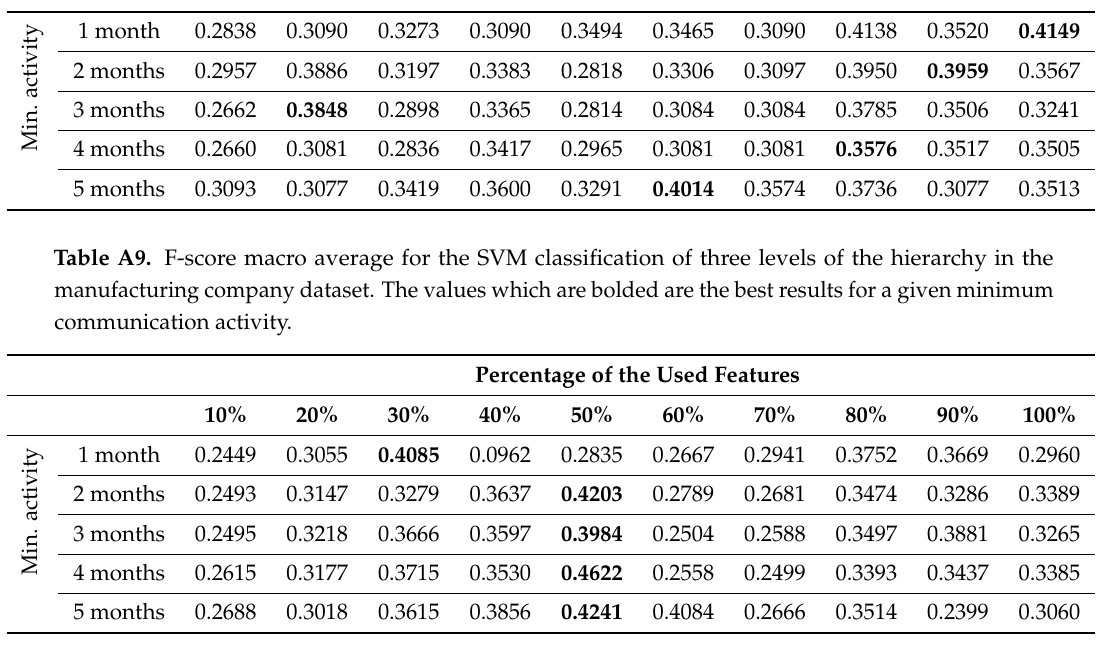
Table A10. F-score macro average for the collective classification of three levels of the hierarchy in the manufacturing company dataset. The values which are bolded are the best results for a given minimum communication activity.